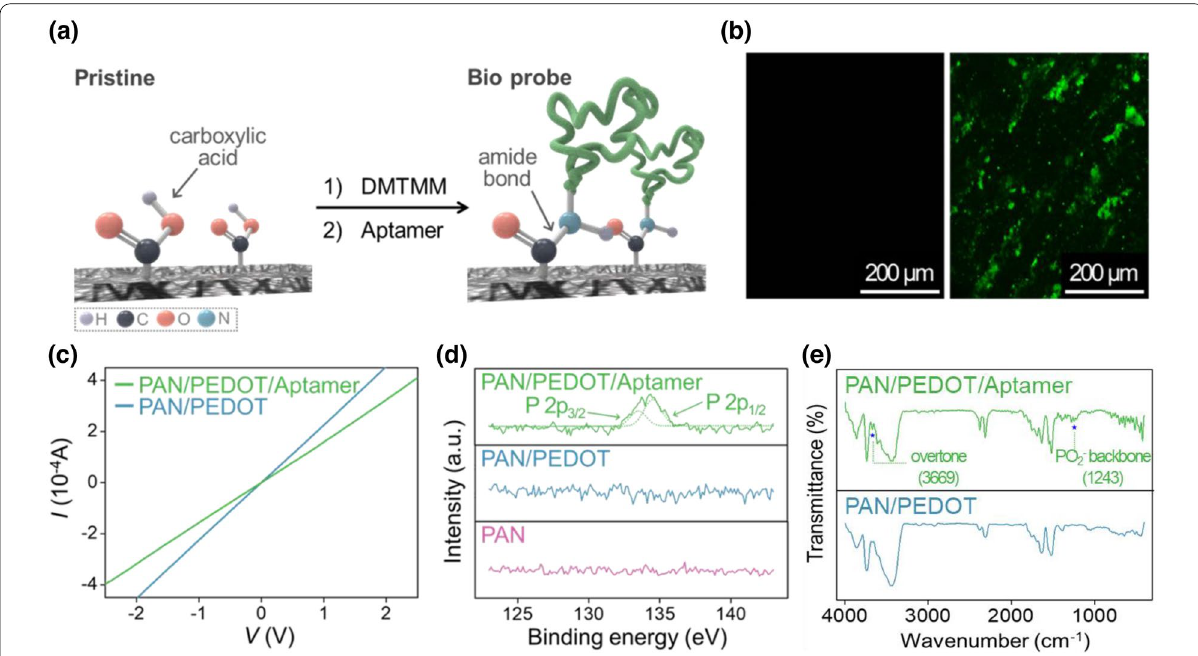
Fig. 2 Characteristics of the aptamer-immobilized serotonin sensor. a Schematic illustration of the aptamer-immobilized electrode. b Fluorescence images of the surface-modified films with aptamers (left: aptamer alone; right: fluorescent probe-linked aptamer). c I-V curve of the surface-immobilized serotonin detection sensor platform. d XPS data with a P 2p peak, demonstrating aptamer attachment on the PEDOT film. e FT-IR data of the PEDOT nanohybrids after aptamer immobilization